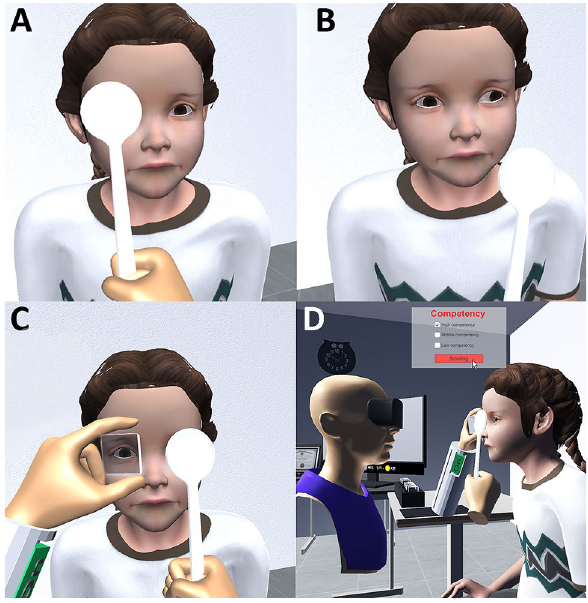
Figure 2. The virtual examination of virtual patients using an occluder and prisms implemented in virtual reality. (A,B) The cover-uncover test in a patient with left exotropia. (C) The prism cover test. (D) A user and a patient from the perspective of a third party.